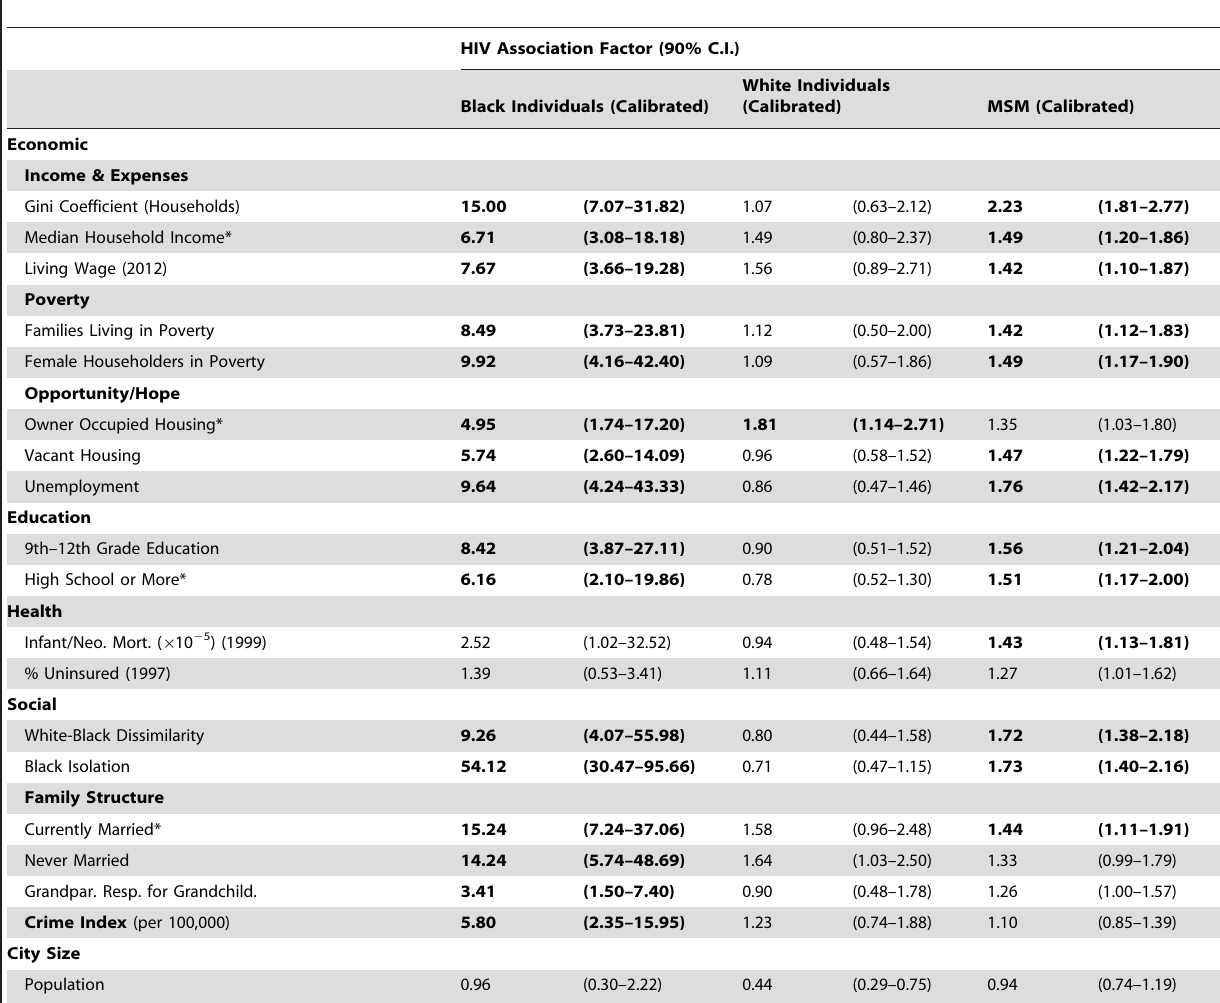
Table 4. Calibrated HIV incidence for select populations from 1998–2002 as a function of socioeconomic and demographic metrics of 80 U.S. cities in 2000 (unless otherwise